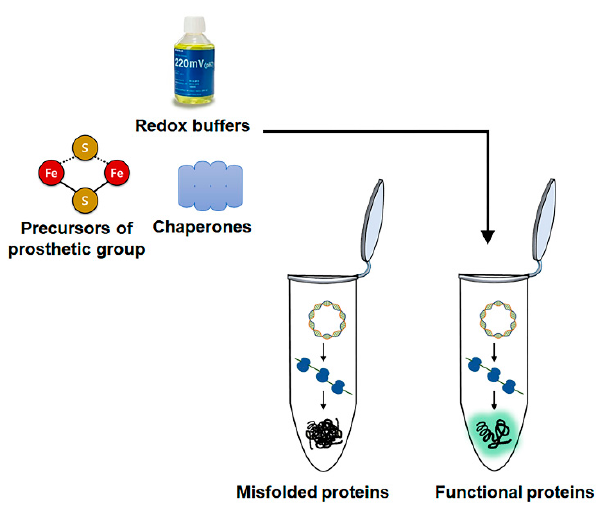
Figure 4. Enhanced production of functional enzymes by direct additions of folding effectors. The open nature of cell-free protein synthesis allows direct additions of various chemicals and biomolecules that assist proper folding of desired enzymes.